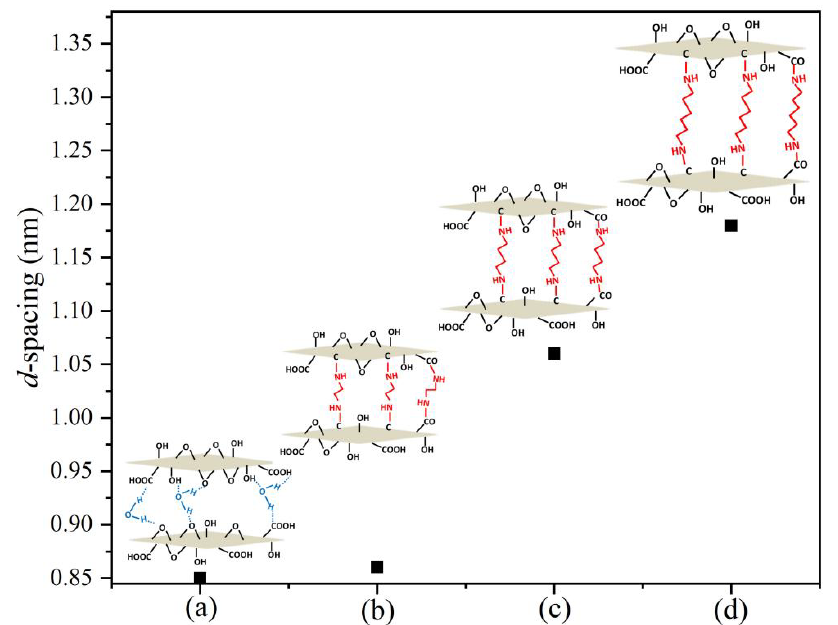
Figure 4. Change of spacing between BPPO/GO and three composite membranes: ( a ) BPPO/GO; ( b ) BPPO/EDA-GO; ( c ) BPPO/BDA-GO; ( d ) BPPO/HDA-GO.